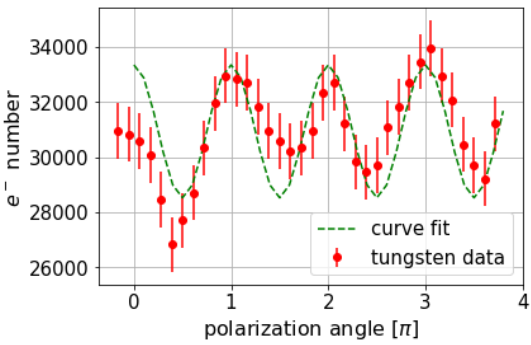
Figure 8. Electron emission as a function of polarization of incident light relative to the surface normal vector of the blade surface. Measurements performed at 6 × 10 12 W/cm 2